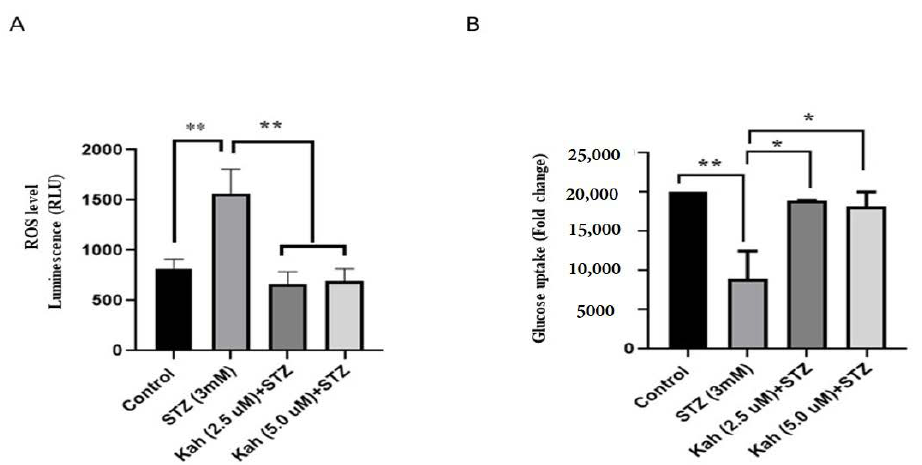
Figure 4. Effect of kahweol on ROS production and glucose uptake in STZ-treated cells. ( A ) Levels of ROS were determined by fluorescence intensity in STZ-treated cells for 3 h or pre-incubated with kahweol for 24 h, followed by STZ-treatment compared to control cells. ( B ) Glucose uptake assessment as determined by flow cytometry in STZ-treated cells for 3 h or pre-incubated with kahweol for 24 h followed by STZ-treatment compared to control cells. Data are shown from three independent experiments. * p < 0.05 and ** p < 0.01 Bars represent mean ±